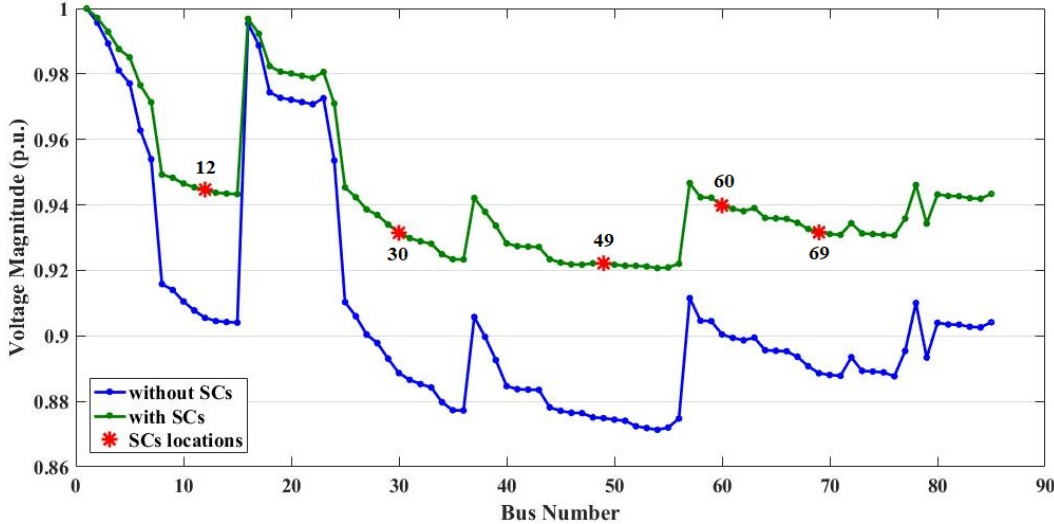
Figure 6. Voltage profile of the 85-bus system considering full-load level using PODESCA.